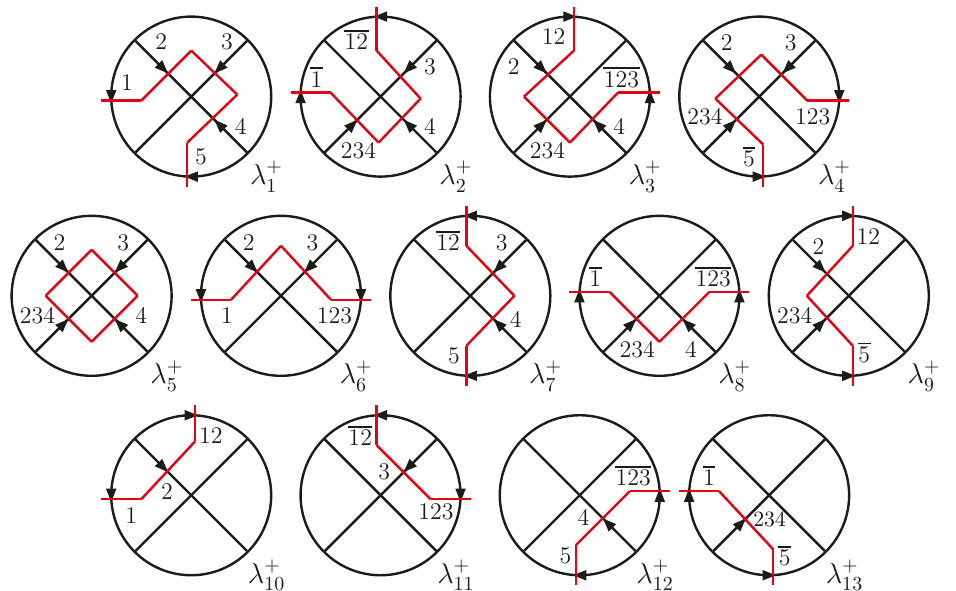
configurations are obtained by i configurations shown here. The set number i